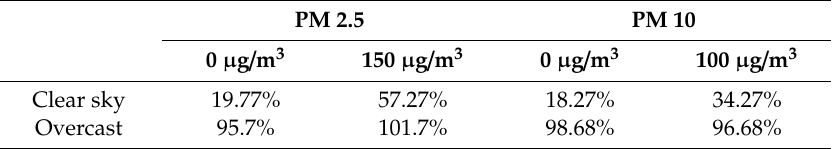
Table 7. Diffuse irradiance factor based on the concentration of PM at specific points. Table 7. Di ff use irradiance factor based on the concentration of PM at specific